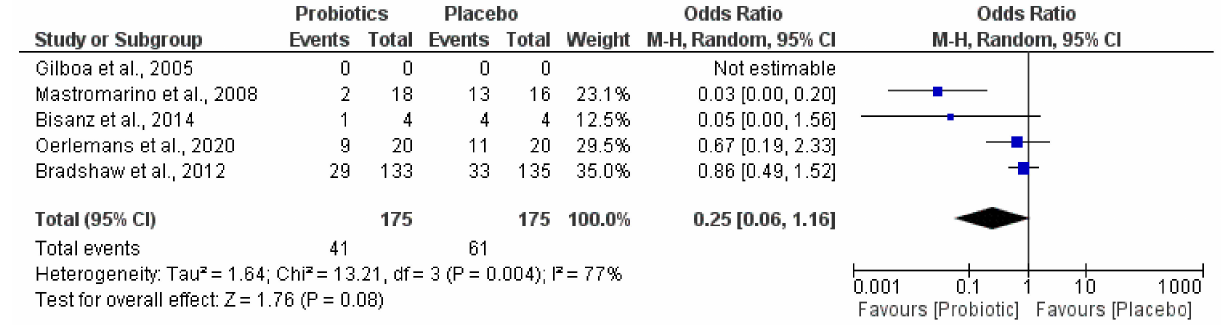
Figure 5. Effect of vaginal probiotics for modulation reduction in abnormal microbiota.